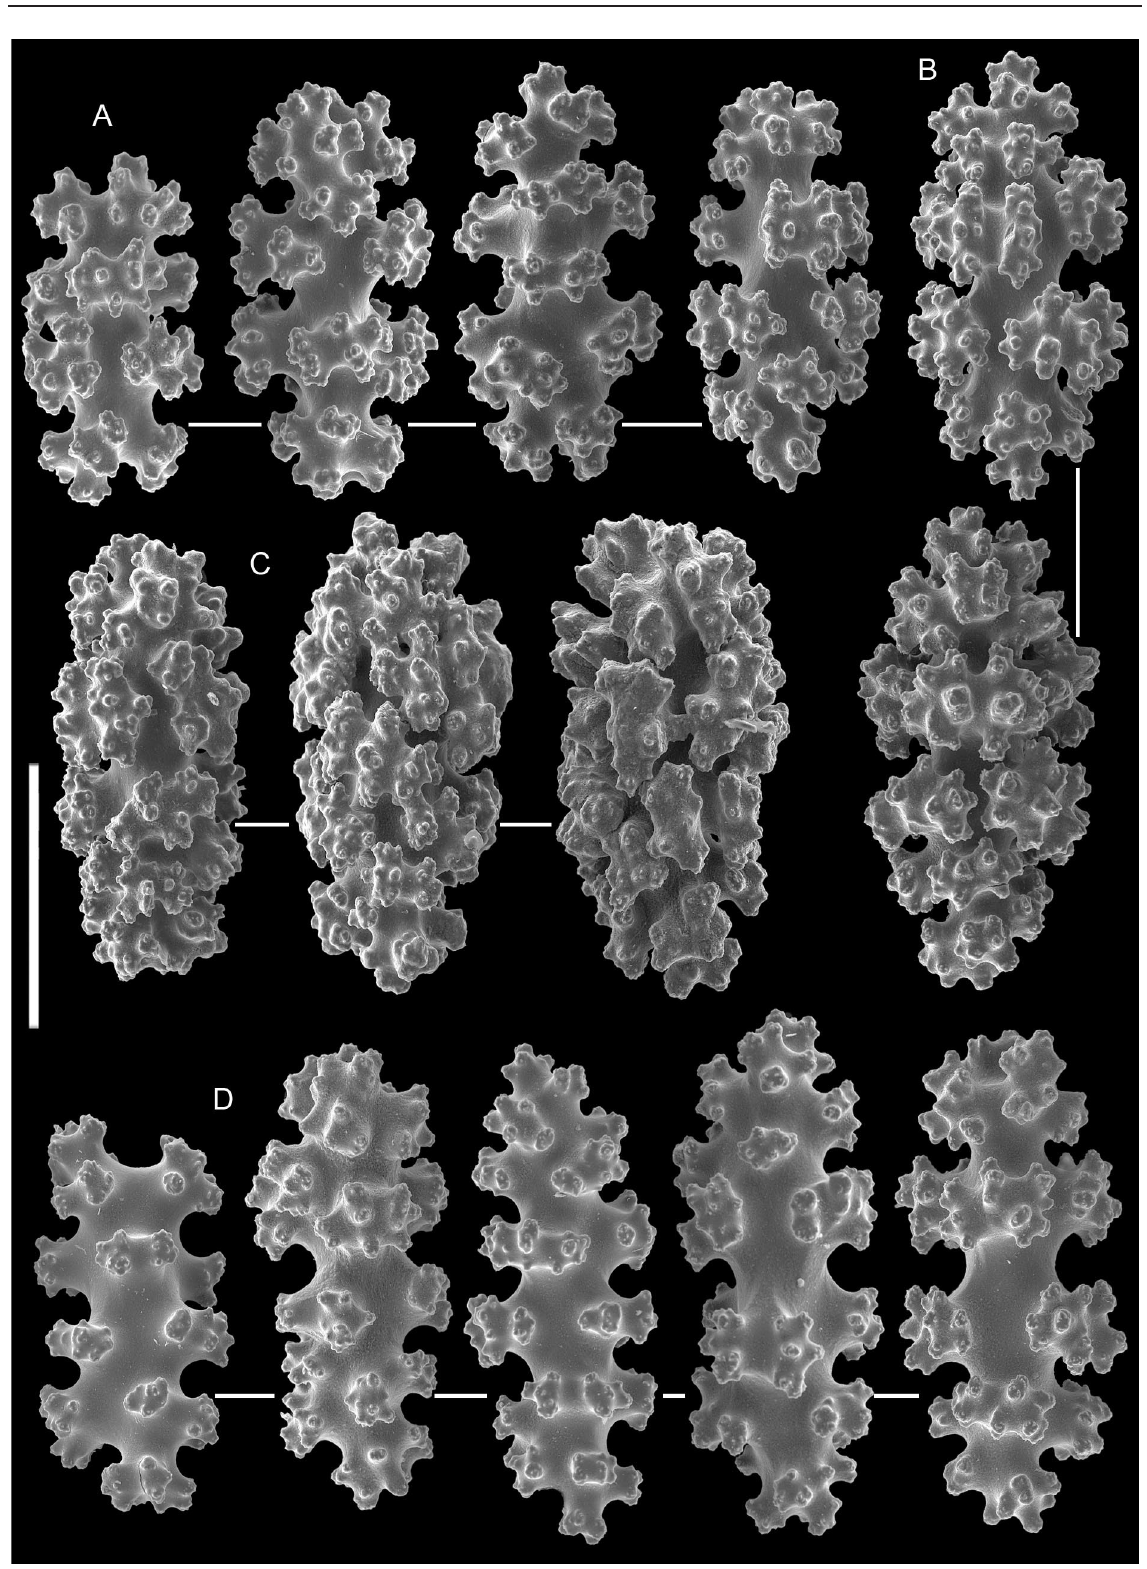
Fig. 10. Calcigorgia lukini sp. nov., holotype MIMB 20710, sclerites. A . Capstans from polyp body wall. B . Well calcified capstans from polyp body wall. C . Ovals from polyp body wall. D . Capstans (8-radiate) from the coenenchyme. Scale bar = 0.1